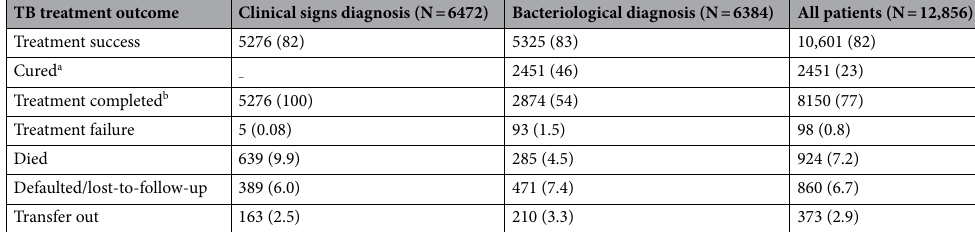
Table 3. TB treatment outcomes after 6 months of anti-TB treatment. a Proportion of treatment success defined following WHO guideline. b Proportion of treatment success defined following WHO guideline.